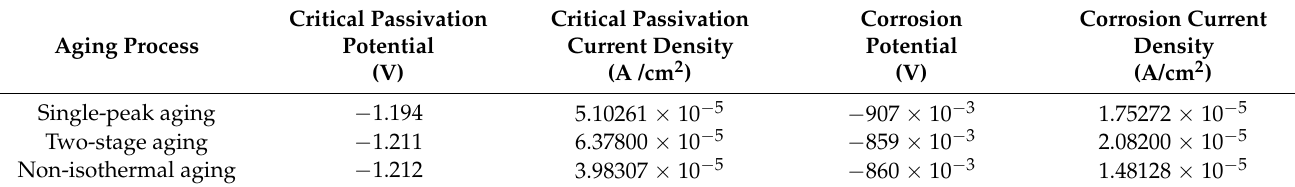
Table 7. The corrosion parameters the 7N01 extrusion aluminum alloy after different